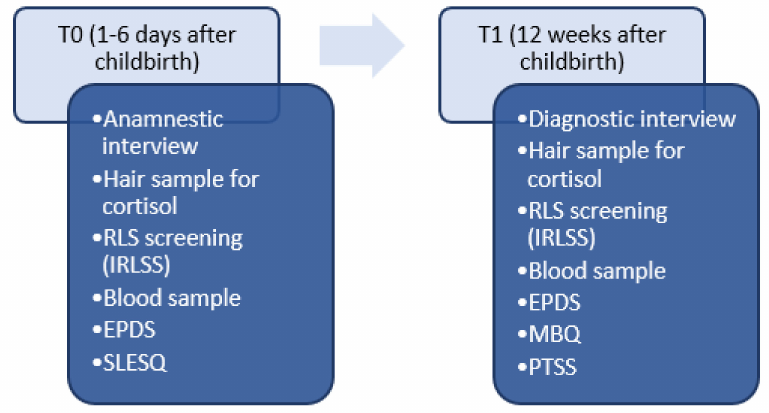
Figure 1. Study overview. RLS = Restless Legs Syndrome, IRLSS = International Restless Legs Syndrome Rating Scale, EPDS = Edinburgh Postnatal Depression Scale, SLESQ = Stressful life events screening